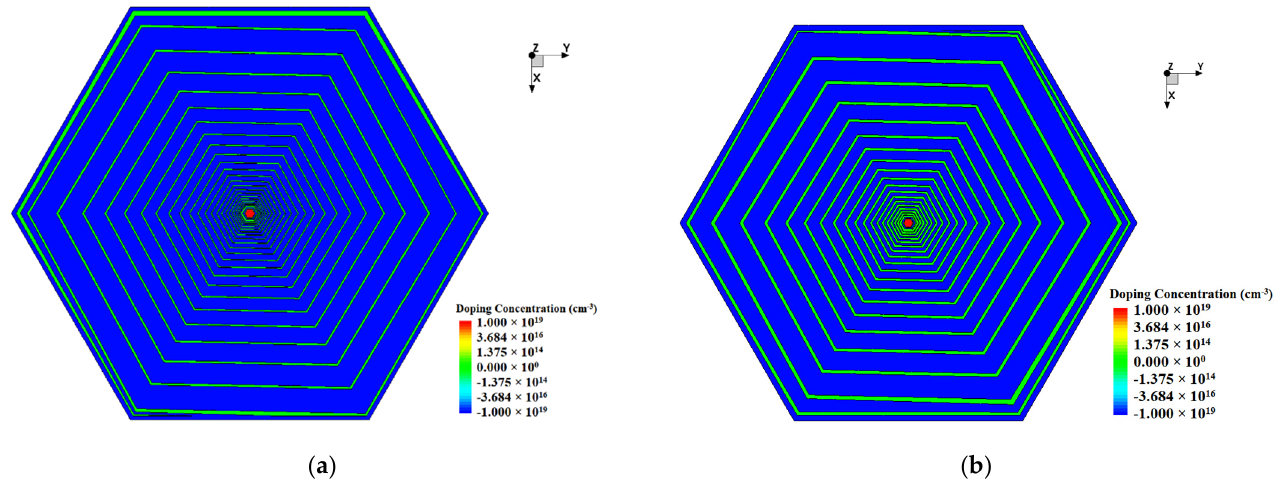
Figure 2. Front side view of the SDD: ( a ) gap 10 µm; ( b ) gap 25 µm.